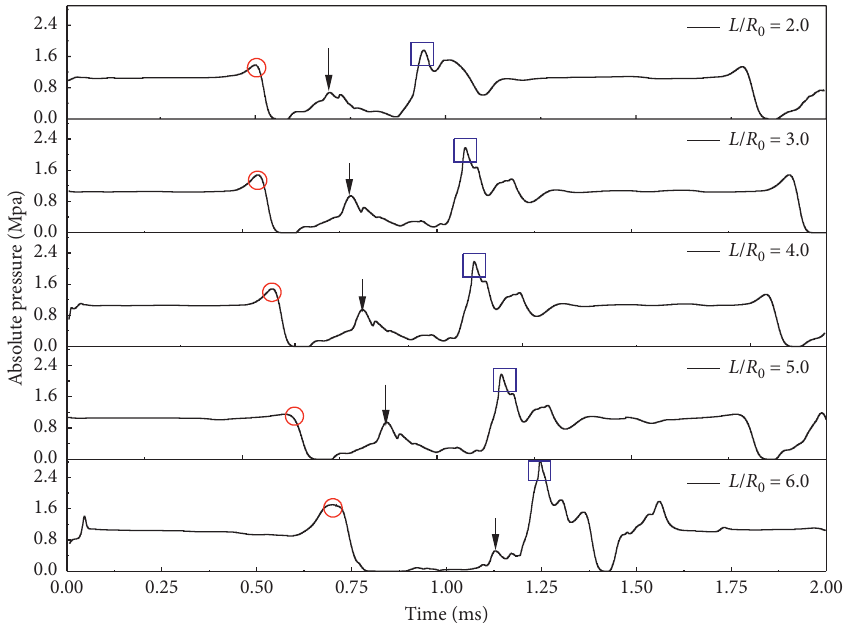
Figure 10: Pressure pulsation at the monitoring point